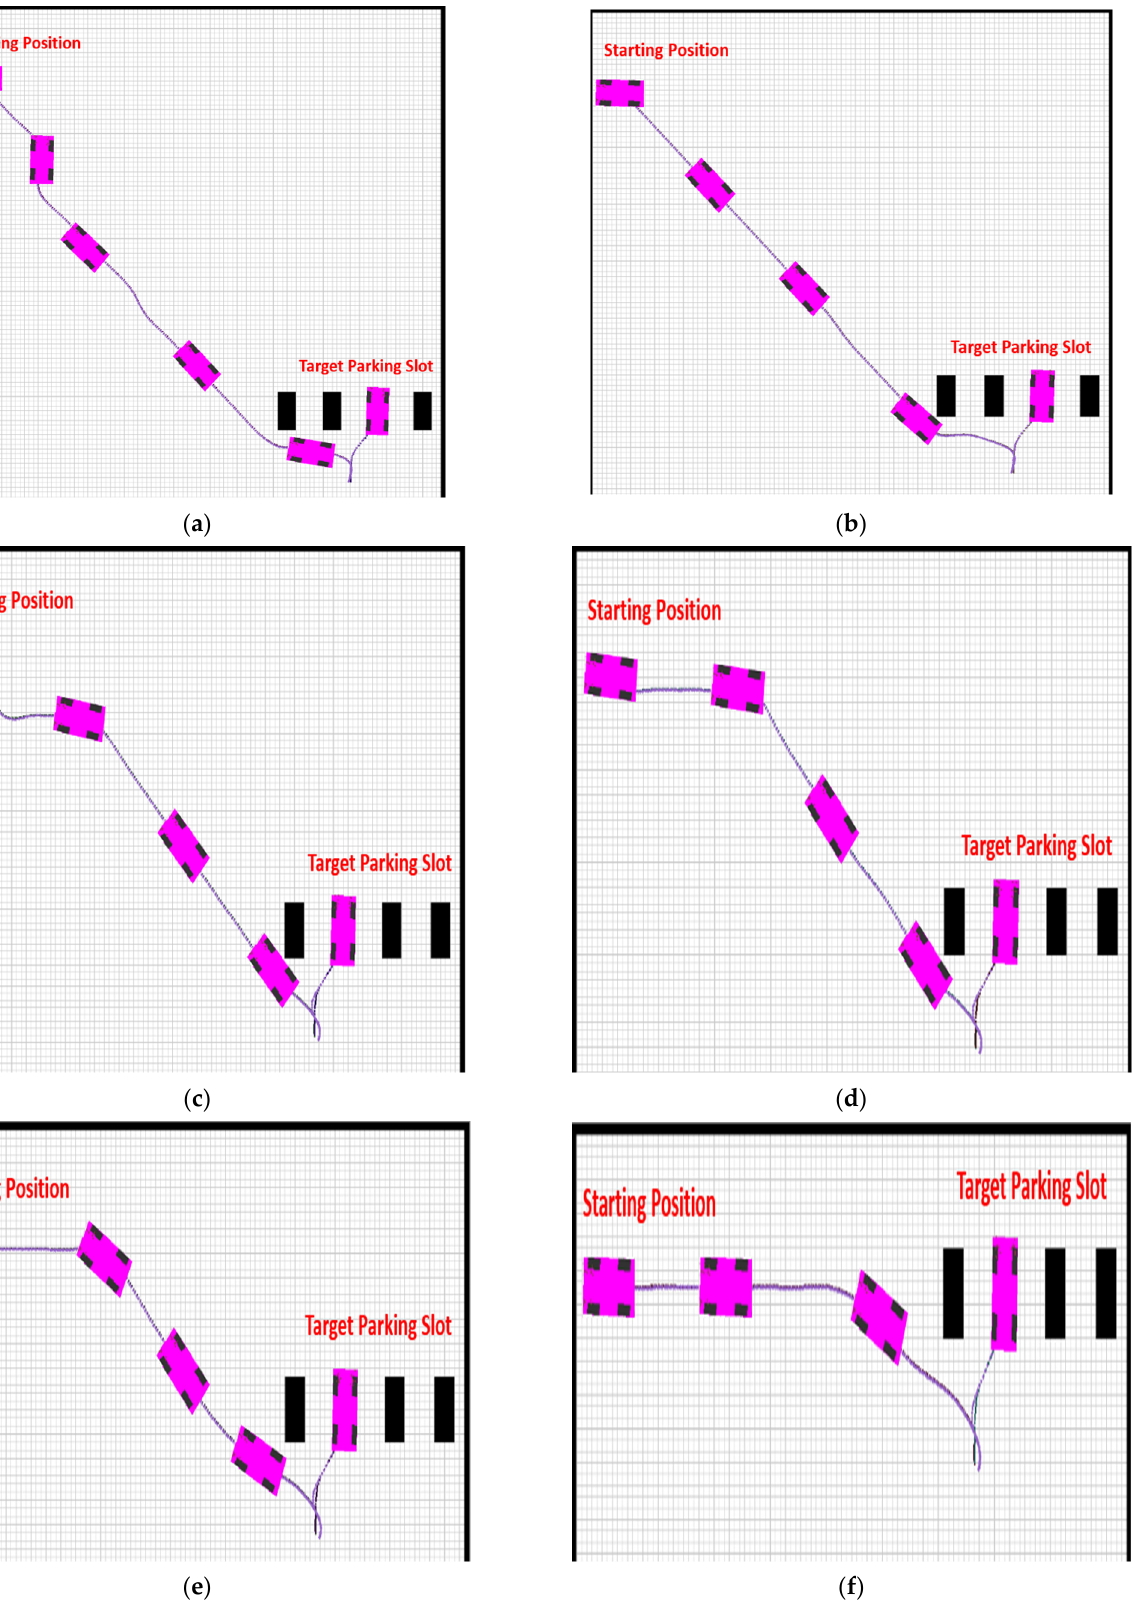
Figure 9. Simulation results in six different scenarios illustrating the proposed ARP system. ( a ) Case 1. ( b ) Case 2. ( c ) Case 3. ( d ) Case 4. ( e ) Case 5. ( f ) Case 6.